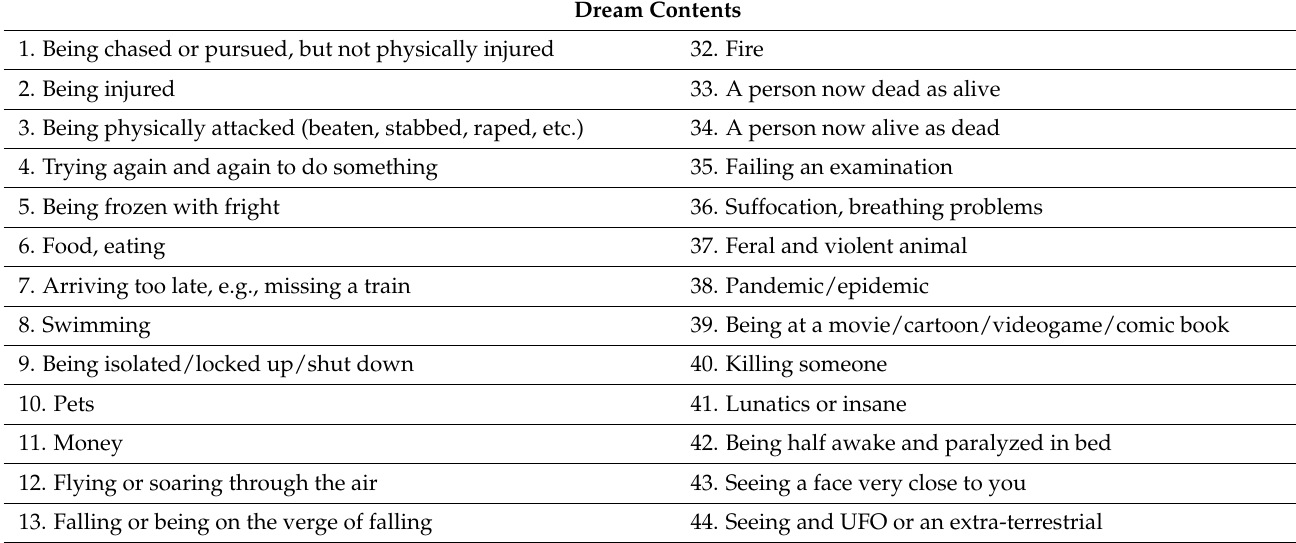
Table 1. Categorization of dream